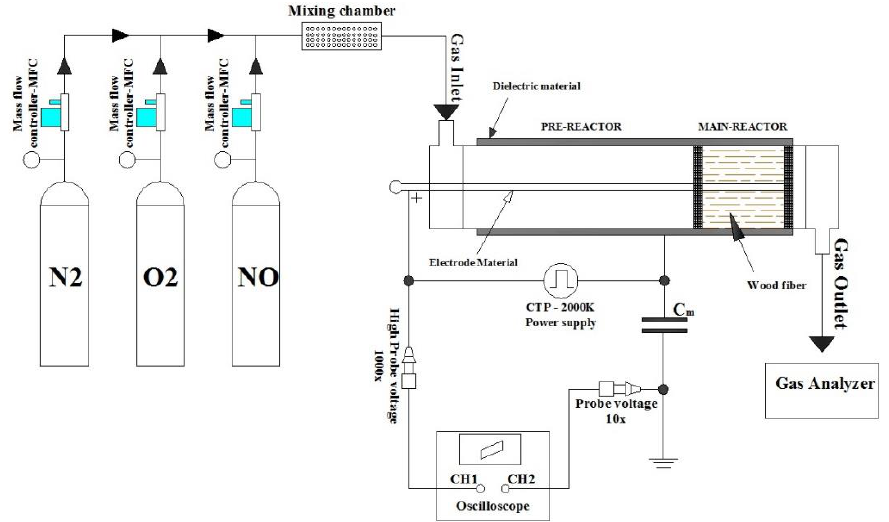
Figure 6. Schematic of experimental